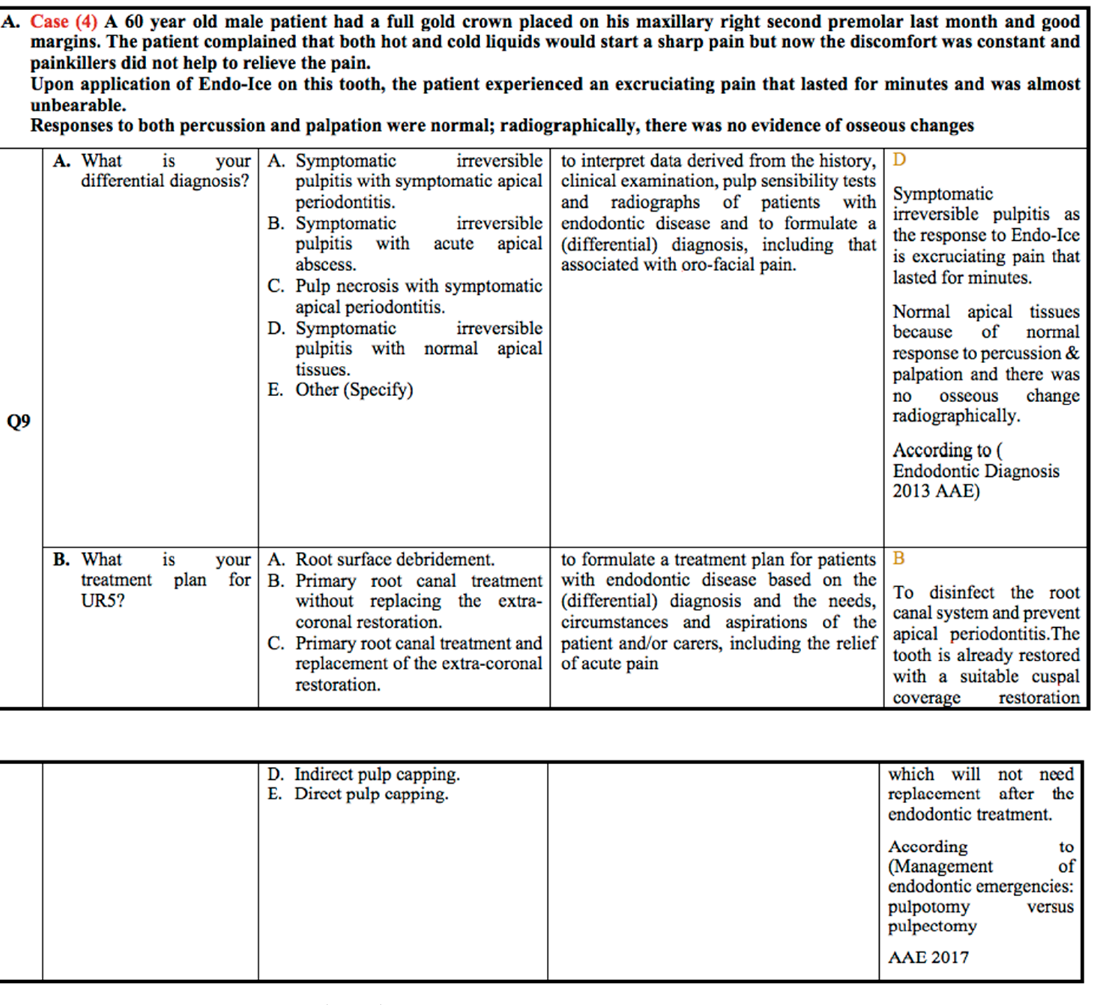
Figure 4. Clinical case scenario 4.